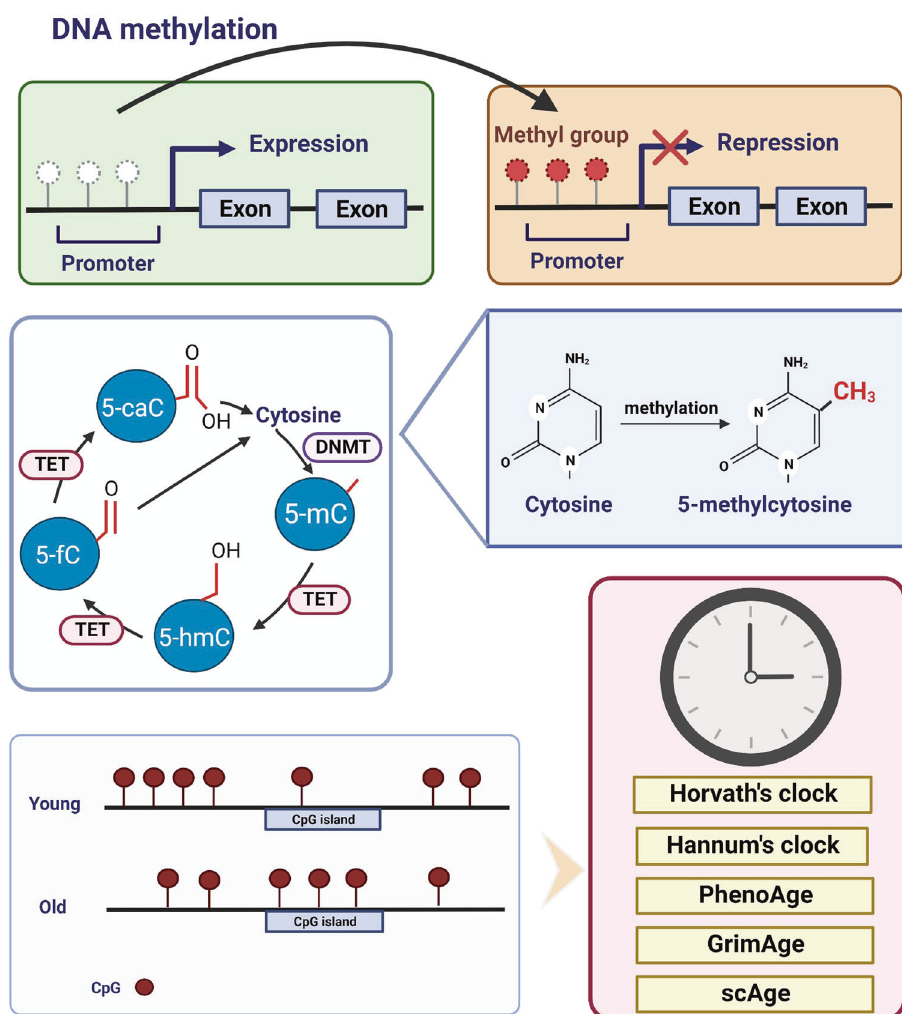
Fig. 3 The mechanism of DNA methylation and the epigenetic clock theory of aging. Aging is often marked by global DNA hypomethylation, but hypermethylation also occurs at selective CpG islands. DNA methylation at the promoter of a gene often leads to silencing of that gene. DNA methylation at the 5 ʹ cytosine of CpG results in 5-methylcytosine (5-mC). The methylation of DNA is mediated by DNMTs whereas the methyl group on DNA is removed by TET enzymes. TET enzymes oxidize 5-mC to generate 5-mC derivatives, including 5-hydroxymethylcytosine (5-hmC), 5-formylcytosine (5-fC), and 5-carboxylcytosine (5-caC), in mammalian cells. Age estimators, such as Horvath ’ s clock, Hannum ’ s clock, PhenoAge, GrimAge and single-cell age clock (scAge) are based on DNA methylation changes in the